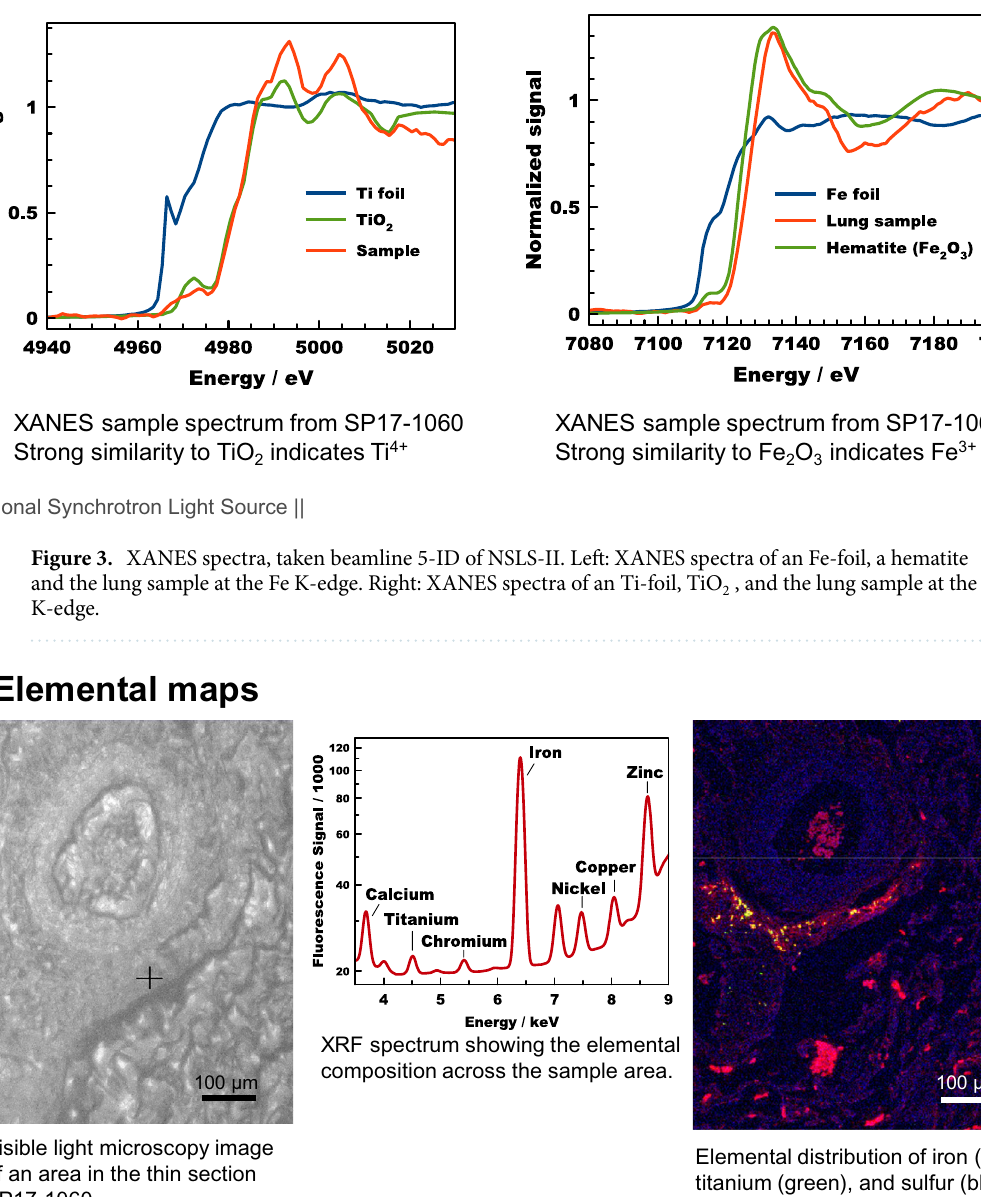
Figure 4. Lung sample. Left: Visible light microscope image of the thin section area investigated using XRF mapping. Right: XRF map of the same area showing the distribution of iron (red) and Ti (green) in front of a sulfur (blue) background. Many Ti particles appear yellow due to the co-localization with